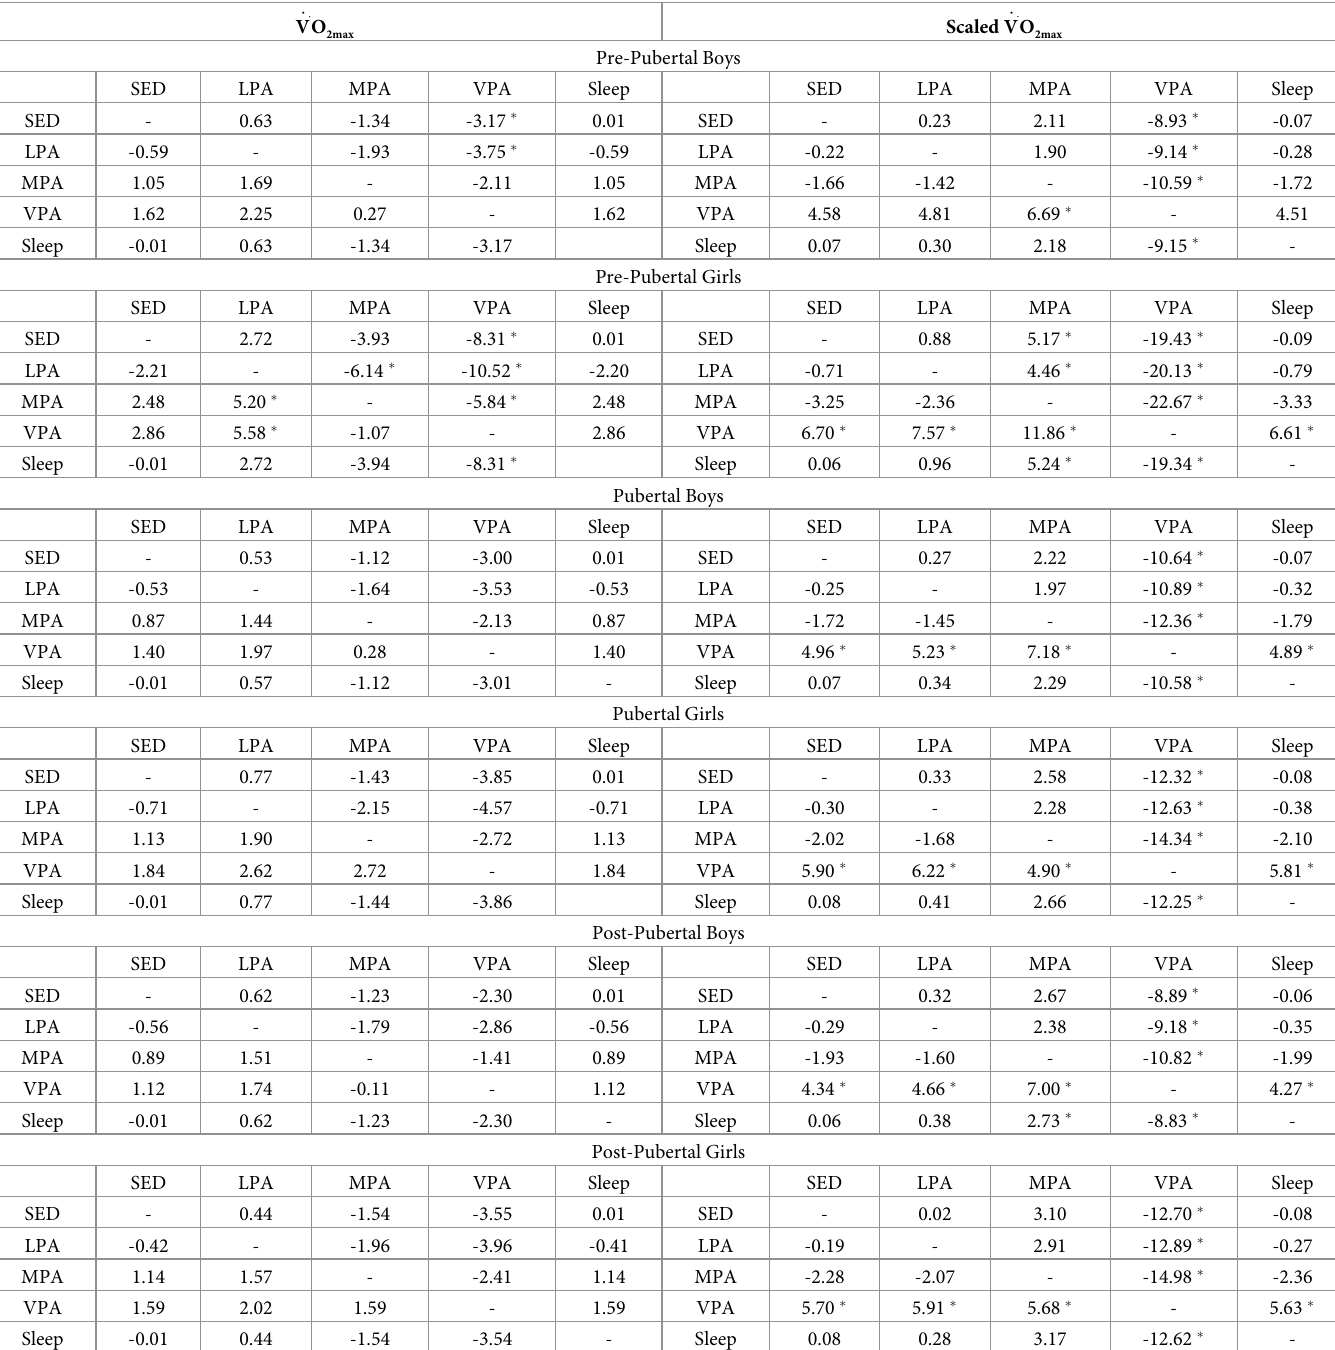
(l � min -1 ) and scaled